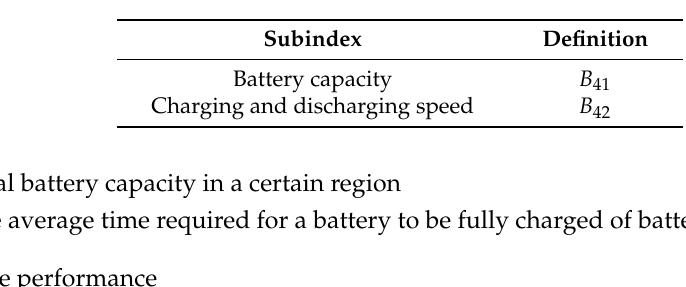
Table 5. Definition of peak shaving capability.